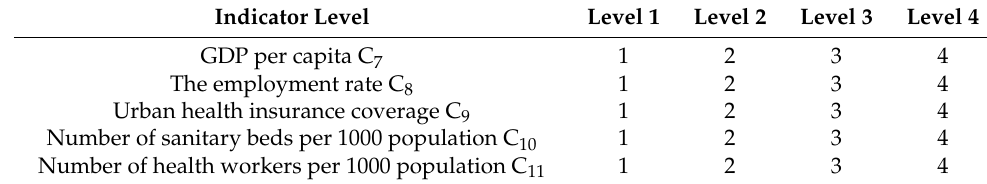
Table 9. Values of recovery evaluation indicator grades.